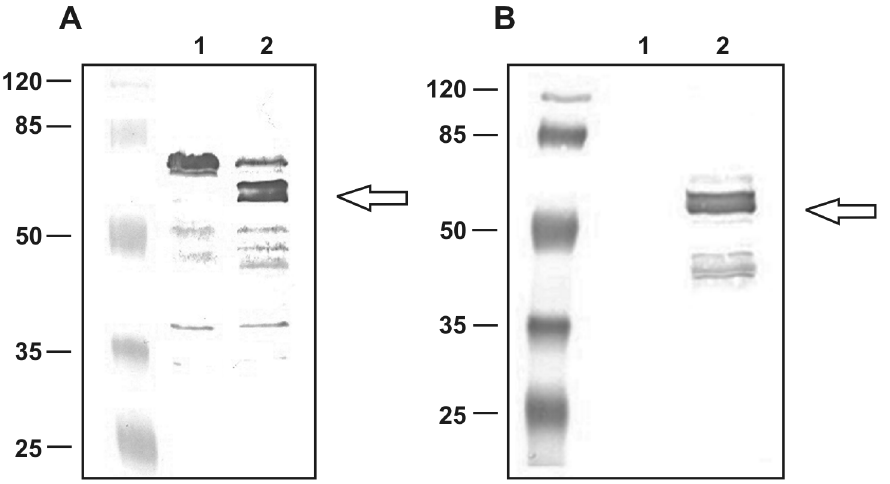
Figure 4. Western blotting analysis of expression of the cot-linker-IL-2 fusion gene. Western blotting analysis with anti-CotB (Panel A) or anti-IL-2 (Panel B) antibodies. Spore coat proteins from spores of the 168 (lane 1) or BKH122 (fusion CotB-GGGEAAAKGGG-IL-2) (lane 2) strain. Each lane of panel A and B was loaded with 20 m g of total proteins. Arrows point to fusion proteins.